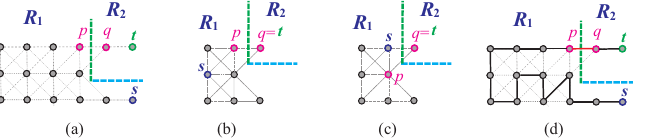
Figure 13. ( a – c ) A vertical and a horizontal separation on C ( m , n ; k , l ; c , d ) under that a (cid:62) 2, c = d = 1, n = 3, and t x > a , and ( d ) a Hamiltonian ( s , t ) -path in C ( m , n ; k , l ; c , d ) for ( a ), where bold lines indicate the constructed Hamiltonian path.